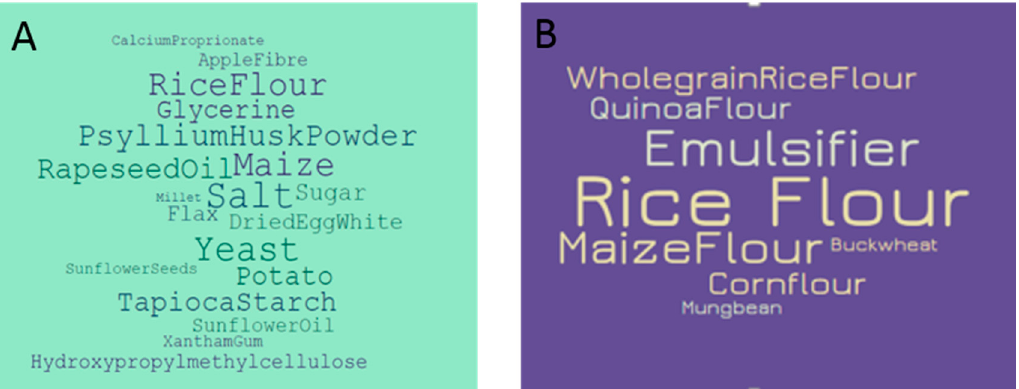
Figure 3. Key ingredients used in gluten-free ( A ) bread products and ( B ) pasta products. Ingredients frequently used in multiple products are indicated by larger font sizes. For a full list of ingredients, please refer to supplementary material.